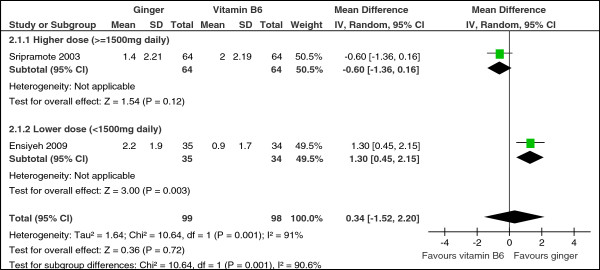
Forest plot of the improvement in nausea symptoms as measured by the change in VAS scores (ginger versus Vitamin B6): subgroup analysis regarding dose (≥1500 mg versus < 1500 mg).